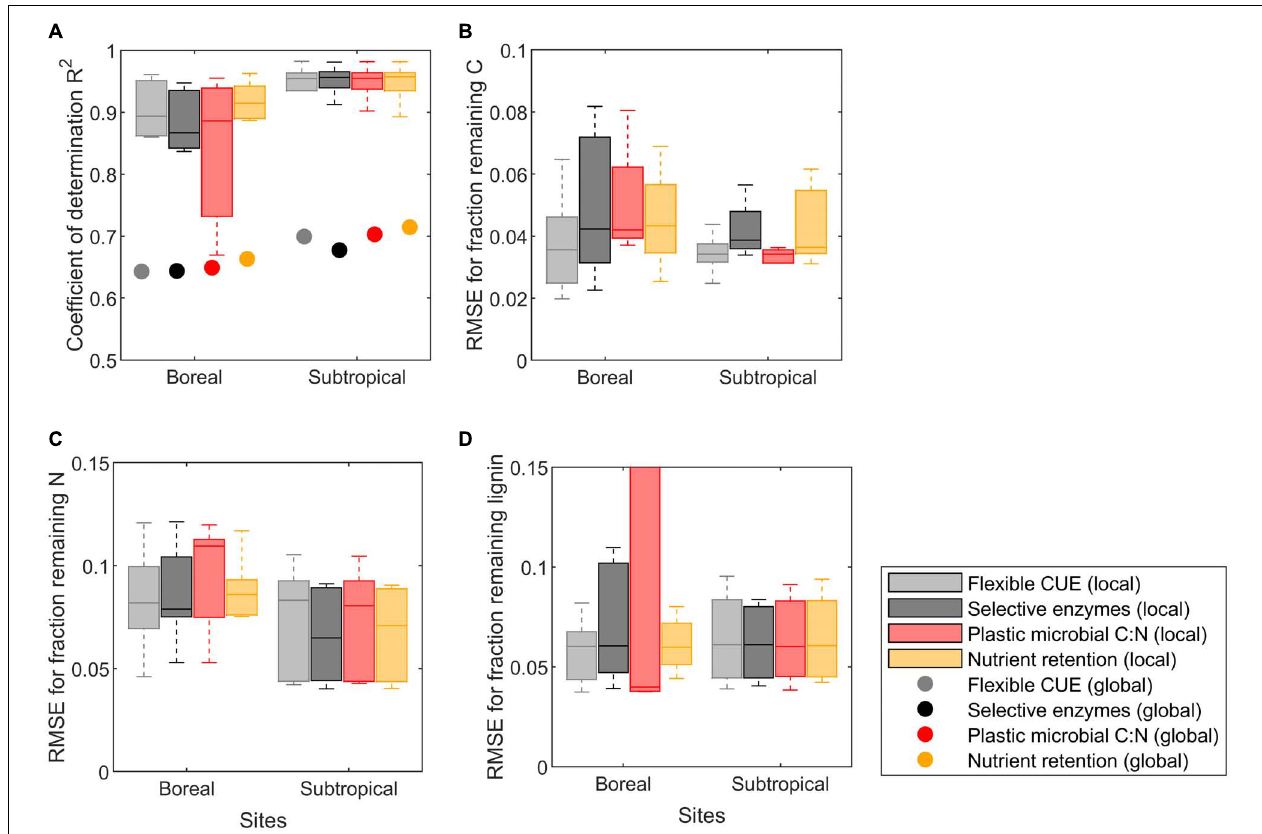
FIGURE 9 | Summary of model performance for litter datasets in which microorganisms were N limited (only litter from boreal and subtropical sites). Performance is evaluated by (A) the overall coefficient of determination (R 2 ), and the root mean square errors (RMSE) of model fitting to the fractions of remaining: (B) total C, (C) total N, and (D) lignin. RMSE values are non-dimensional because errors refer to the fractions of remaining C, N, and lignin. In panel (A) , results from both the local (box plots) and the global (points) parameter optimization approaches are shown for comparison. Performance metrices are grouped by dataset (ordered based on their climate; Table 4 ) and resource use modes (color coded according to the legend). Each box indicates median and quartiles, and whiskers cover the data range excluding